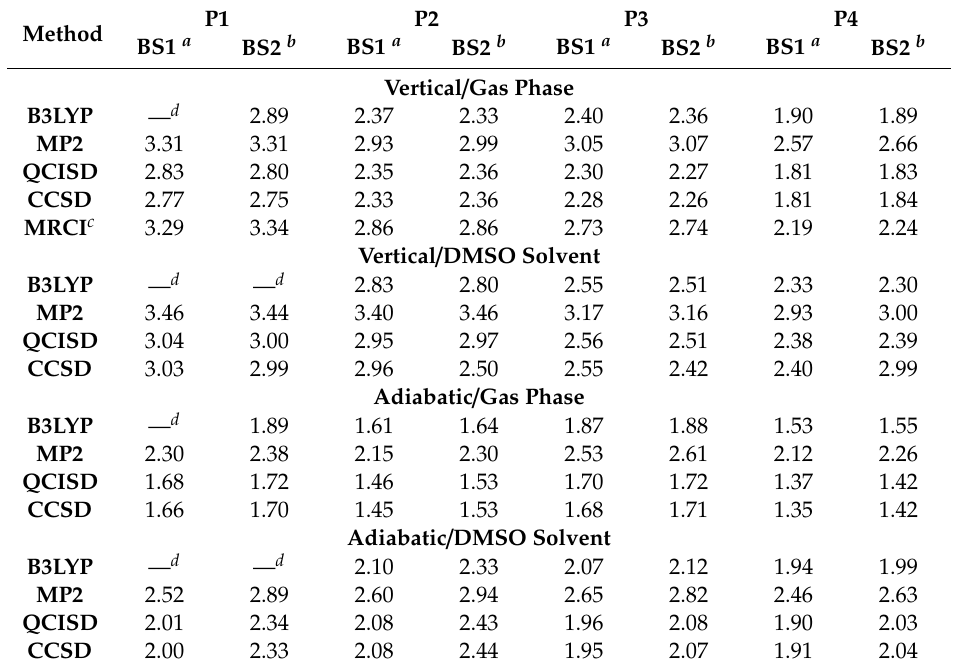
Table 2. Singlet-triplet ( E ST ) energy di ff erences (in eV) for the investigated systems in the gas phase and DMSO